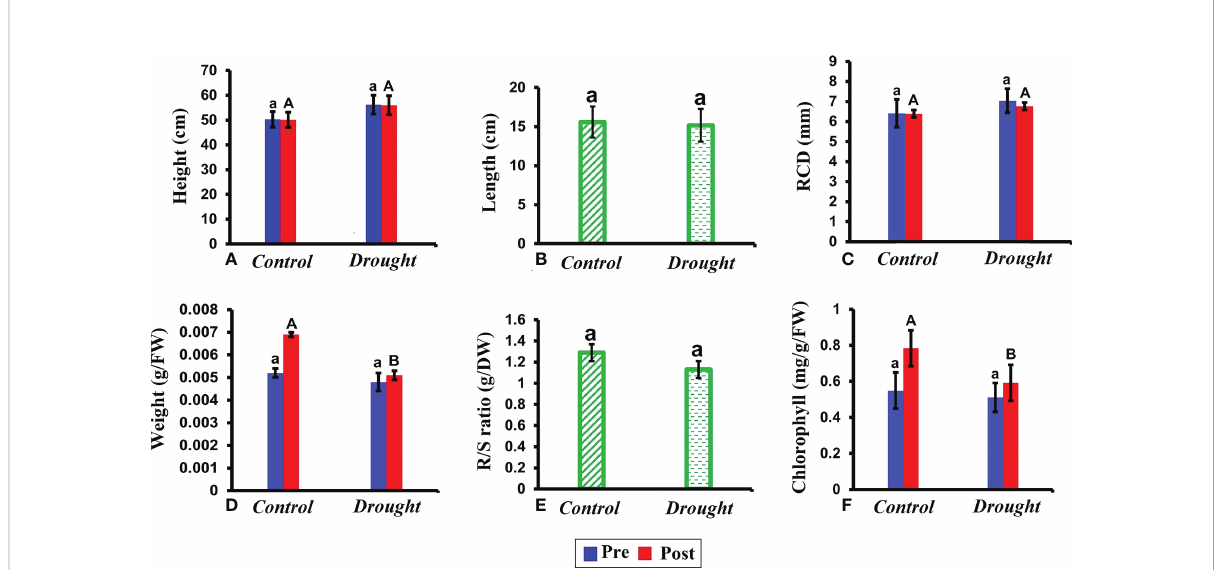
FIGURE 2 Morphological and physiological responses of P.strobus seedlings under drought. (A) plant height measured before and after the treatment period 32 DAT (B) root length measured in control and drought plants (C) root collar diameter (RCD) recorded 32 DAT (D) fresh leaf weight recorded before and after 32 DAT (E) root/shoot ratio measured after the treatment period (F) total chlorophyll content measured in leaves of control and drought plants before and after the treatment period. Results represent that short term severe drought has not caused drastic morphologically changes, rather caused physiological changes in the leaf fresh weight, chlorophyll pigment content and R/S ratio index. Means denoted with different letters indicate signi fi cance at p<0.05.